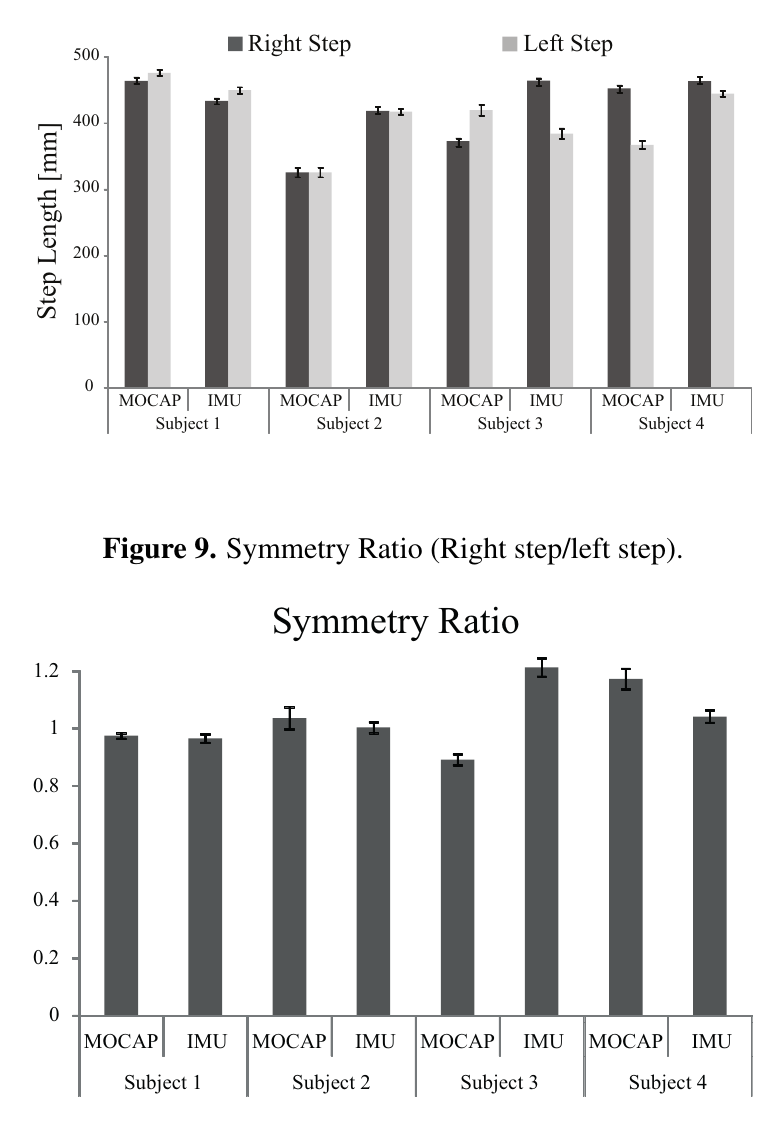
Figure 8. Right and Left Step Lengths.